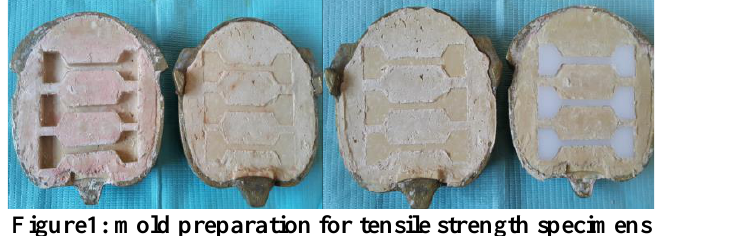
Figure1: mold preparation for tensile strength specimens